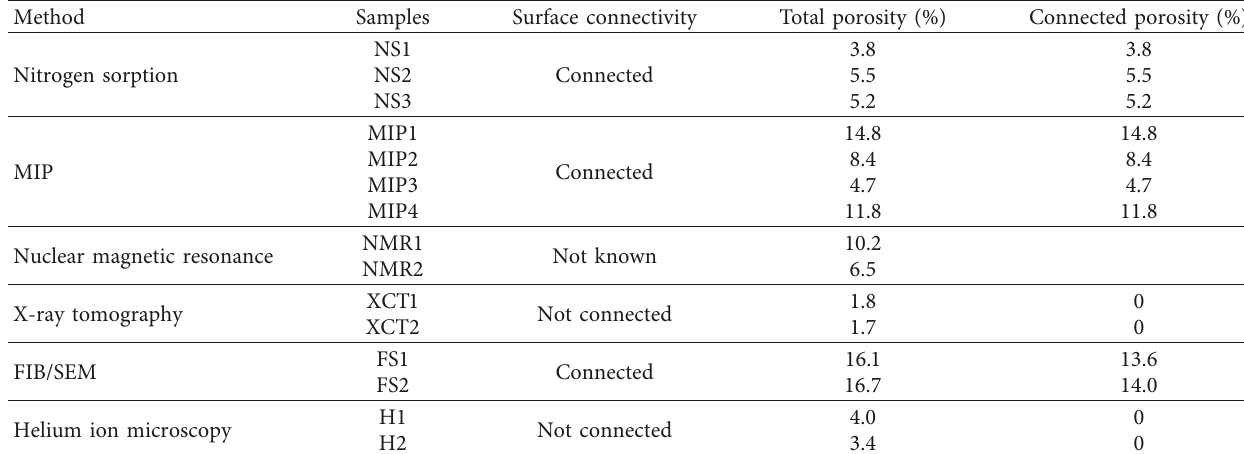
Figure 14: Pore size distribution of HIM images with varying image resolution: (a) cumulative porous volume; (b) relative porous volume. Table 5: Pore connectivity of porous